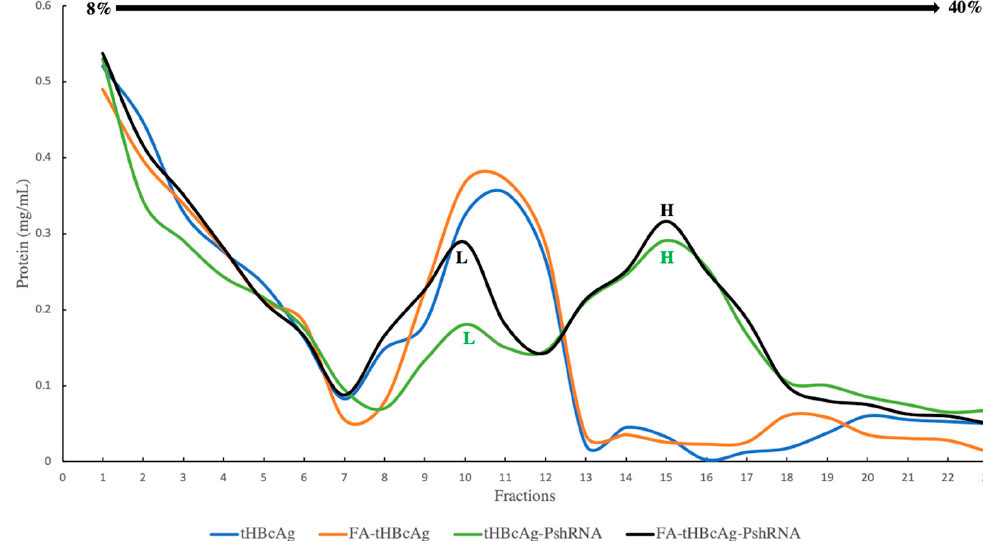
Figure 2. Sucrose density gradient ultracentrifugation of different tHBcAg VLP samples. tHBcAg samples that underwent plasmid (PshRNA) packaging and folic acid (FA) conjugation processes were separated using sucrose density gradient (8–40%) ultracentrifugation. The gradient was fractionated, and the total protein in each fraction was determined using the Bradford assay. The arrow on top of the gradient indicates sucrose concentration. tHBcAg (truncated hepatitis B core antigen); FA-tHBcAg (truncated hepatitis B core antigen conjugated with folic acid); tHBcAg-PshRNA (PshRNA packaged with truncated hepatitis B core antigen); FA-tHBcAg-PshRNA (PshRNA packaged with truncated hepatitis B core antigen and conjugated with folic acid). tHBcAg-PshRNA and FA-tHBcAg-PshRNA samples produced two major peaks; lighter density peak (L: fractions 8–12) and heavier density peak (H: fractions 13–18). tHBcAg and FA-tHBcAg samples gave rise to only one major peak (fractions 8–13).